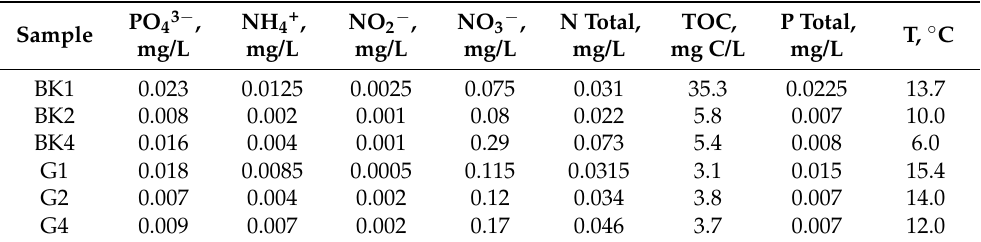
Table 1. Physical and chemical characteristics of water samples. BK1, G1–surface microlayer; BK2, G2—water column; BK4, G4—bottom water. BK—samples taken off the Bol’shiye Koty settlement; G—samples taken off the Bol’shoye Goloustnoye settlement.